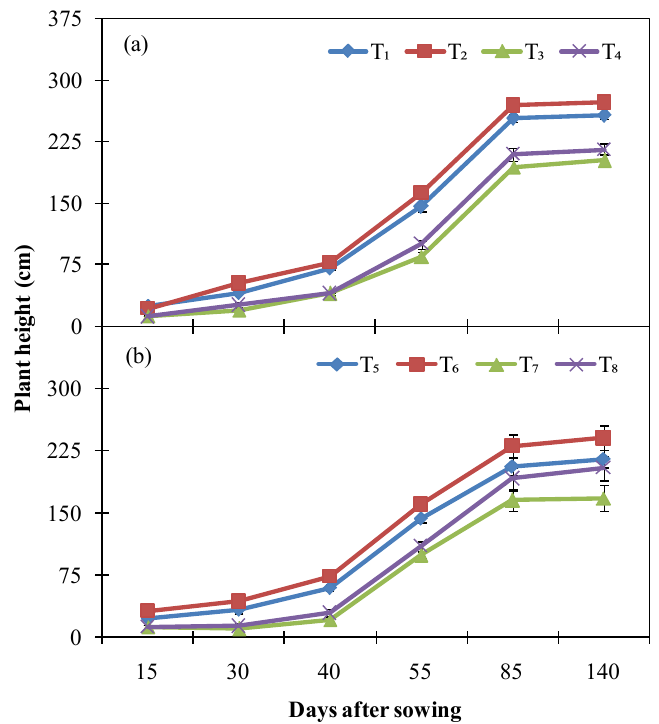
Figure 3. Mean plant height of grain maize crop as affected by irrigation methods (IM), water stress (WS), and mulching practice (MP) under conventional furrow irrigation ( a ) and the alternate furrow irrigation ( b ) method throughout the growing period during 2020–2021. T 1 , T 2 , T 3 , T 4 , T 5 , T 6 , T 7 , and T 8 indicate the combined factor treatments. The values mean ± SE ( n = 3). The error bars are standard errors. Table 4. ANOVA output for the effect of irrigation methods (IM), water stress (WS), and mulching practice (MP) on mean plant height leaves per plant, and leaf area per plant of grain maize on dif- ferent days after sowing (DAS).